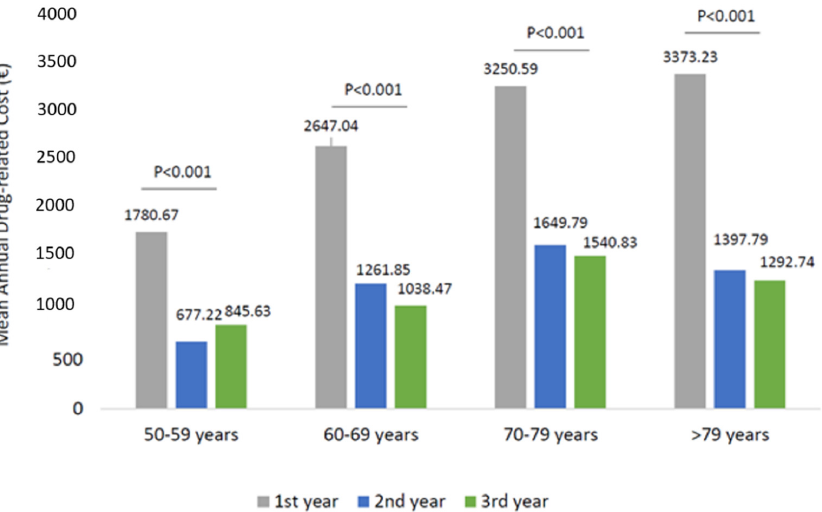
Figure 4. Drug-related costs during the follow-up among patients of wAMD-patients stratified by age classes.